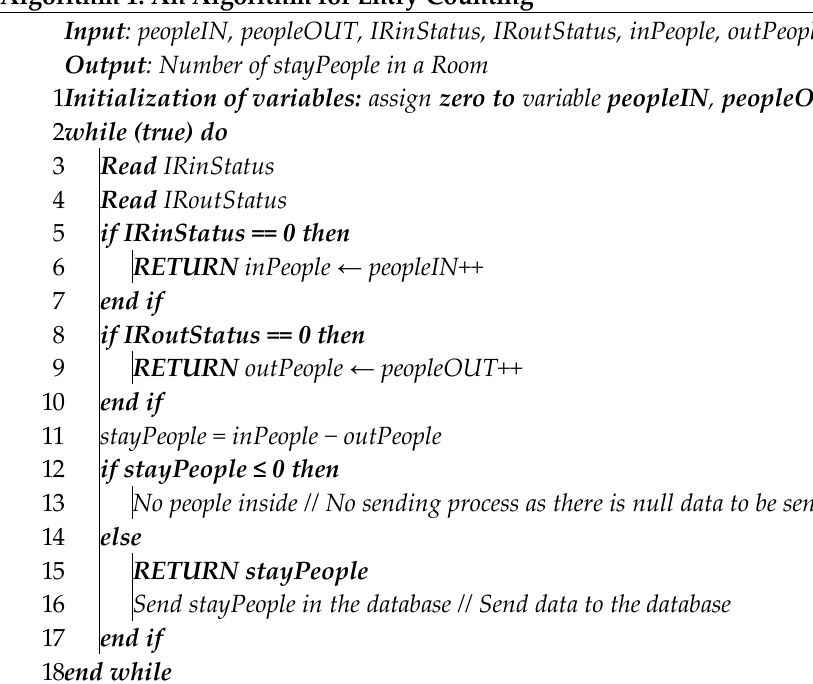
Algorithm 1: An Algorithm for Entry Counting